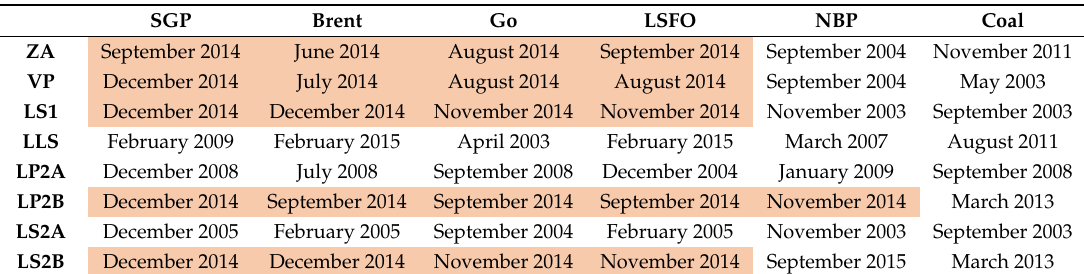
Table 5. Break dates crash model.